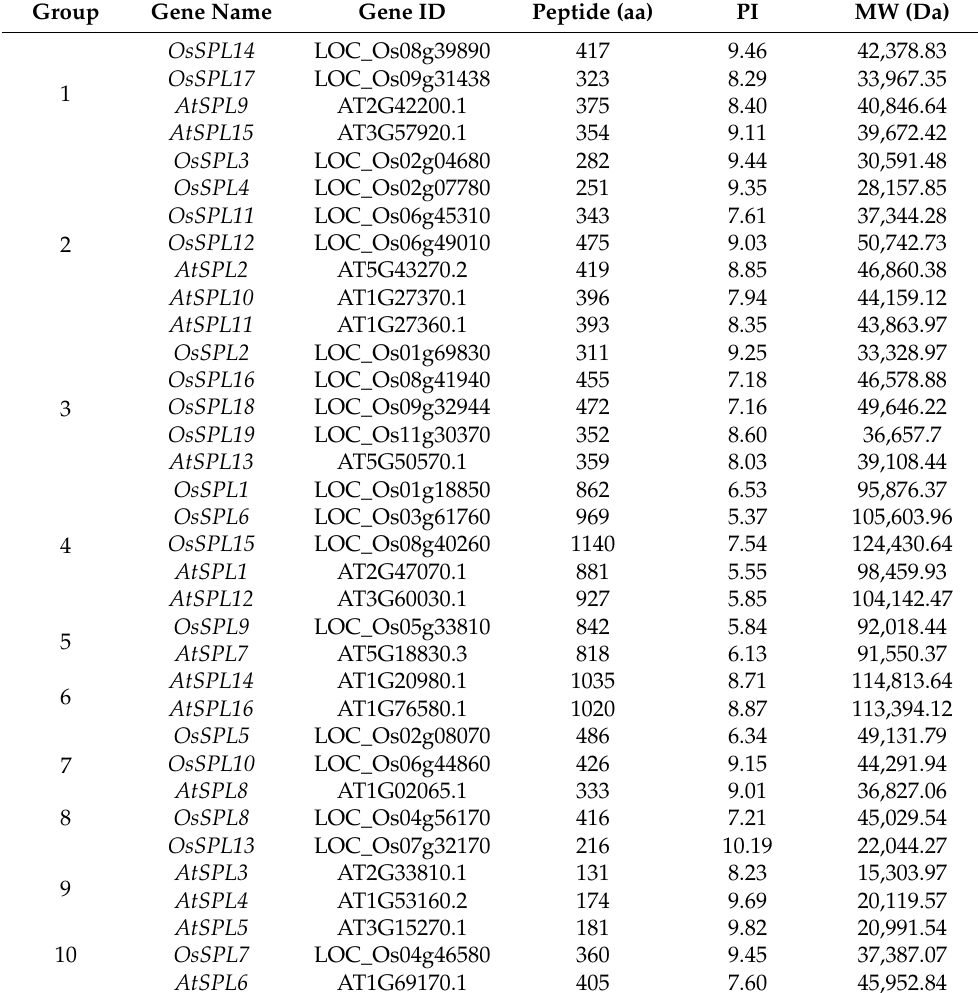
Table 2. Basic information of Oryza sativa and Arabidopsis SPL genes in different evolutionary